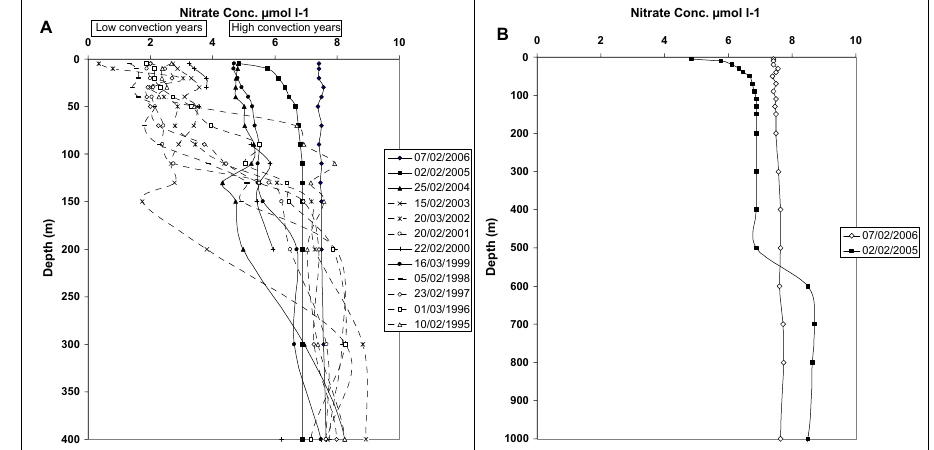
Fig. 8. (A) Nitrate profiles for February/March cruises over the 0–400m layer during each year (1995–2006, see legend). Concentrations are in µmoll − 1 . Solid lines for 2006, 2005, 2004, 2000 and 1999 highlight maximum concentrations in the first 50m layer. (B) Nitrate profiles for February/March cruises in 2005 and 2006 in the 0–1000m layer.